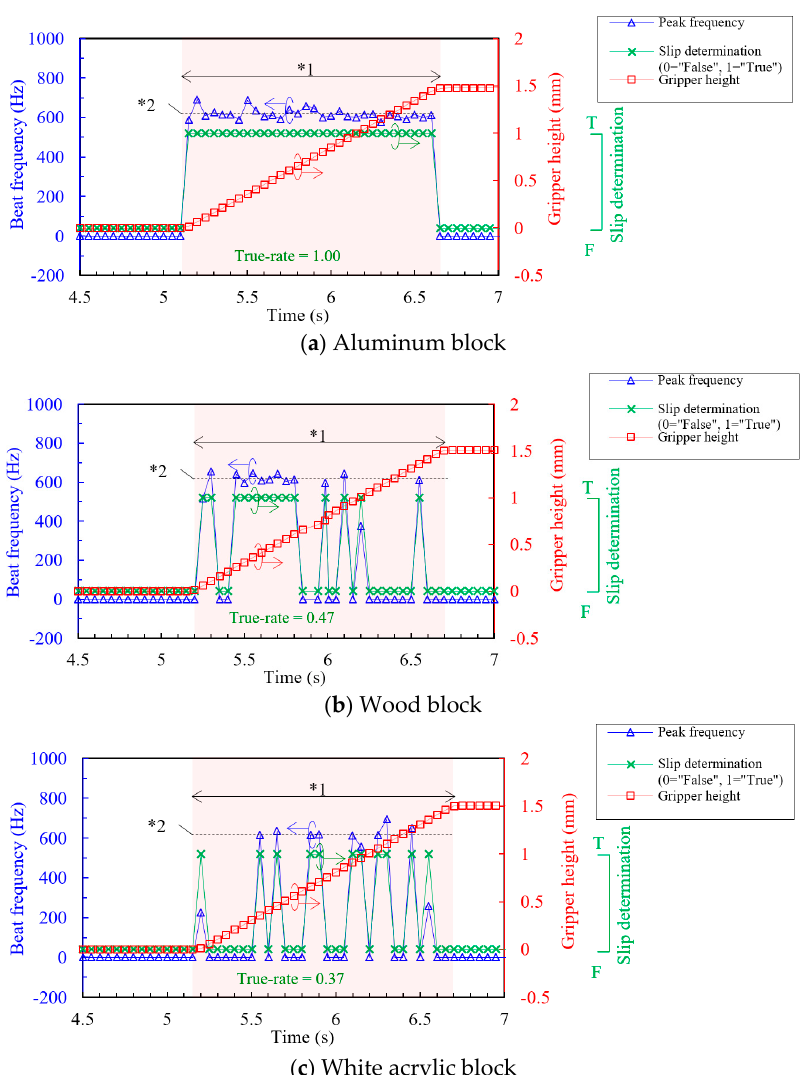
Figure 10. Examples of power spectra of the μ -LDV output in non-slip and slipping condition at 1 mm/s slipping velocity. The green color indicates area of fulfilling slip determination condition: ( a ) Aluminum block; ( b ) Wood block; ( c ) White acrylic block. * 1 Duration of gripper lifting at 1 mm/s. * 2 Theoretical beat frequency at 1 mm/s, calculated by Equation (1).